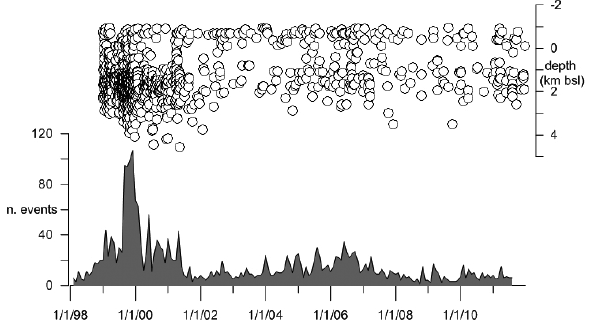
Figure 2. Hypocentral depths of vesuvian VT earthquakes as func- tions of time (upper panel) and the monthly number of VT earth- quakes (lower